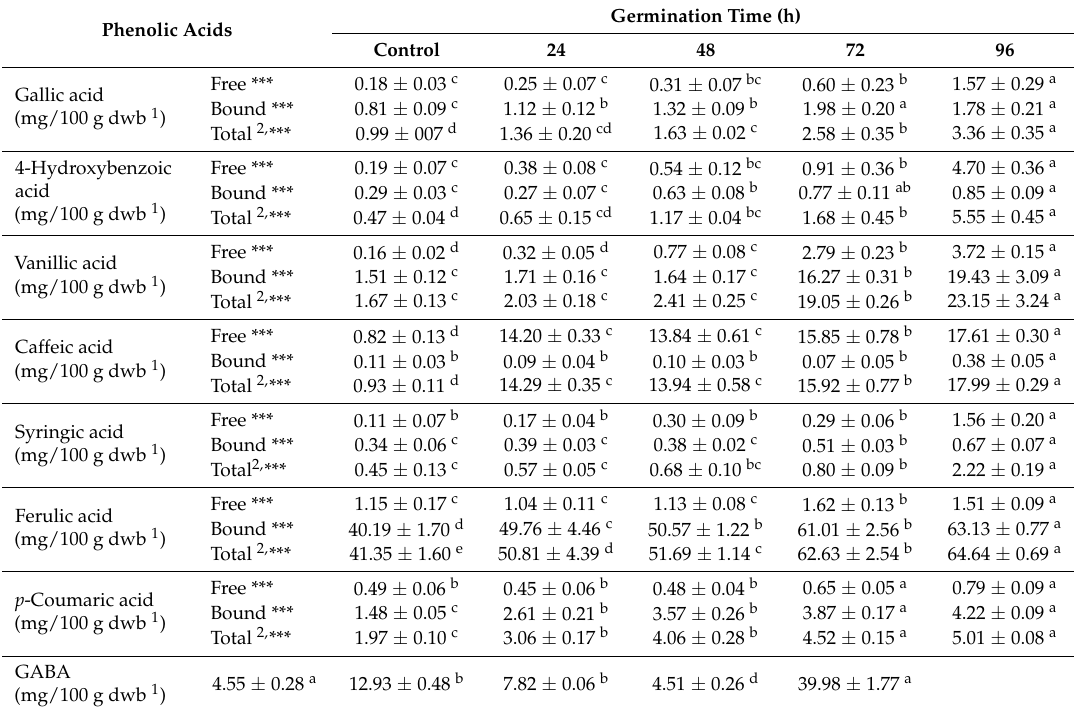
Table 1. Phenolic acid compositions and γ -aminobutyric acid (GABA) contents in ungerminated control wheat grains and in wheat grains at various times (24, 48, 72, and 96 h) during germination. Phenolic